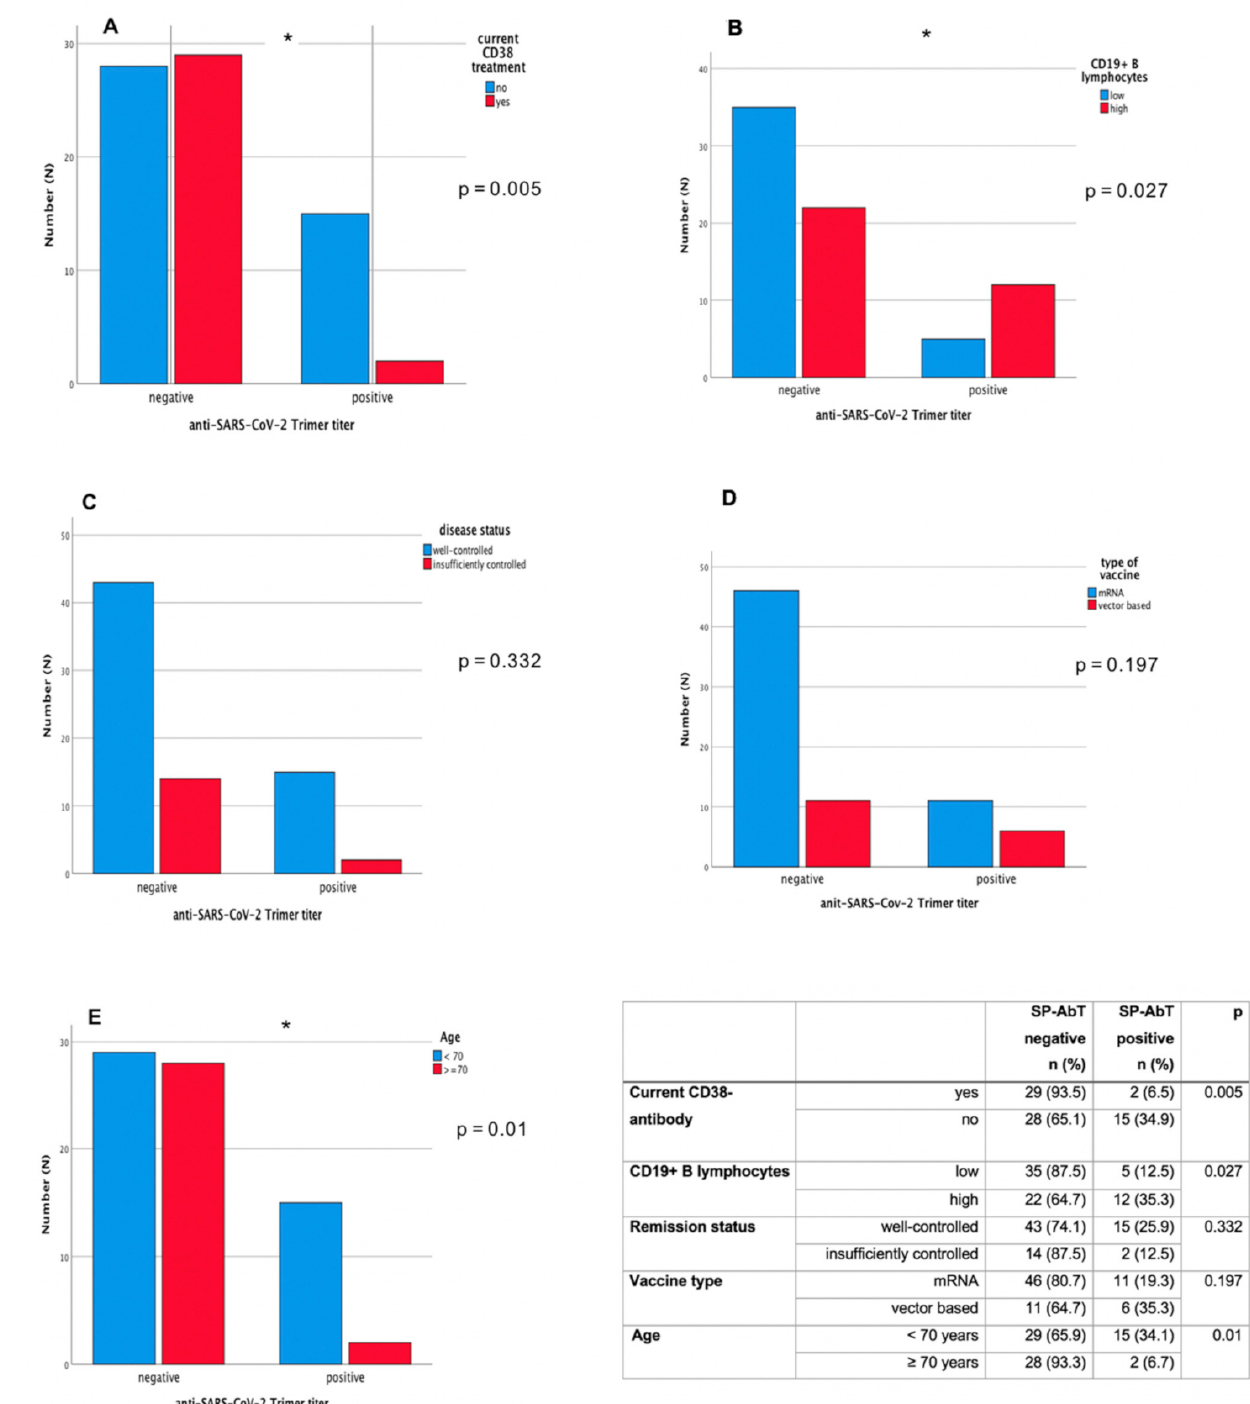
Figure 2. Anti-SARS-CoV-2-antibody response (anti spike-protein-trimer antibody titer) in patients with different character- istics. ( A ) Anti CD38-treatment, ( B ) CD19+ B lymphocyte count, ( C ) disease remission status, ( D ) vaccine type, and ( E ) age. * indicates p <